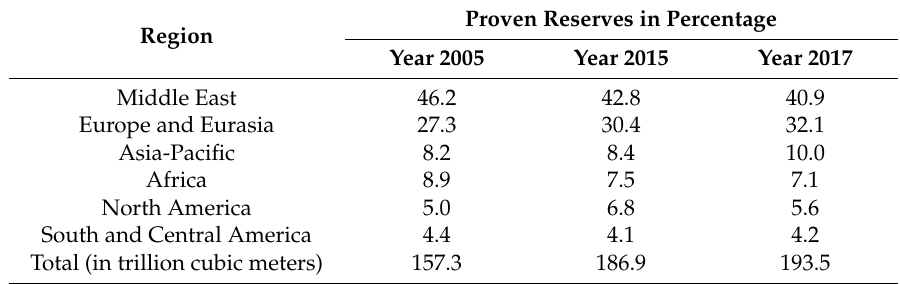
Table 2. Global proven natural-gas reserves, in percentage: comparison between 2005, 2015, and 2017, adapted from British Petroleum (BP)